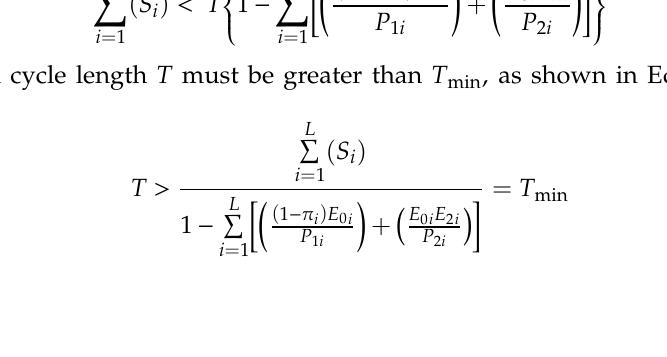
Table A1. E ff ects of di ff erences in π on distinct cost categories in the proposed system.